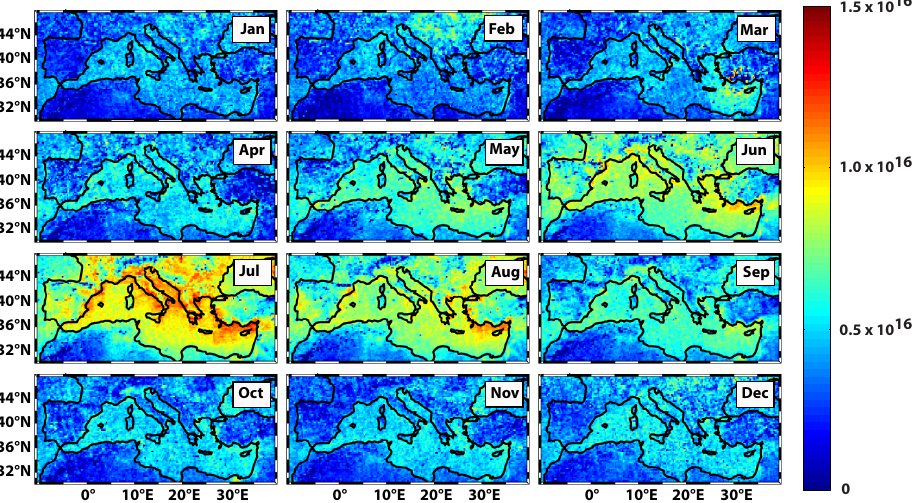
Fig. 3. Monthly averaged (from 2005 to 2007) retrieved formaldehyde vertical columns in units of molecules cm − 2 . The vertical columns are recalculated using corrected AMF values. See text for more details.